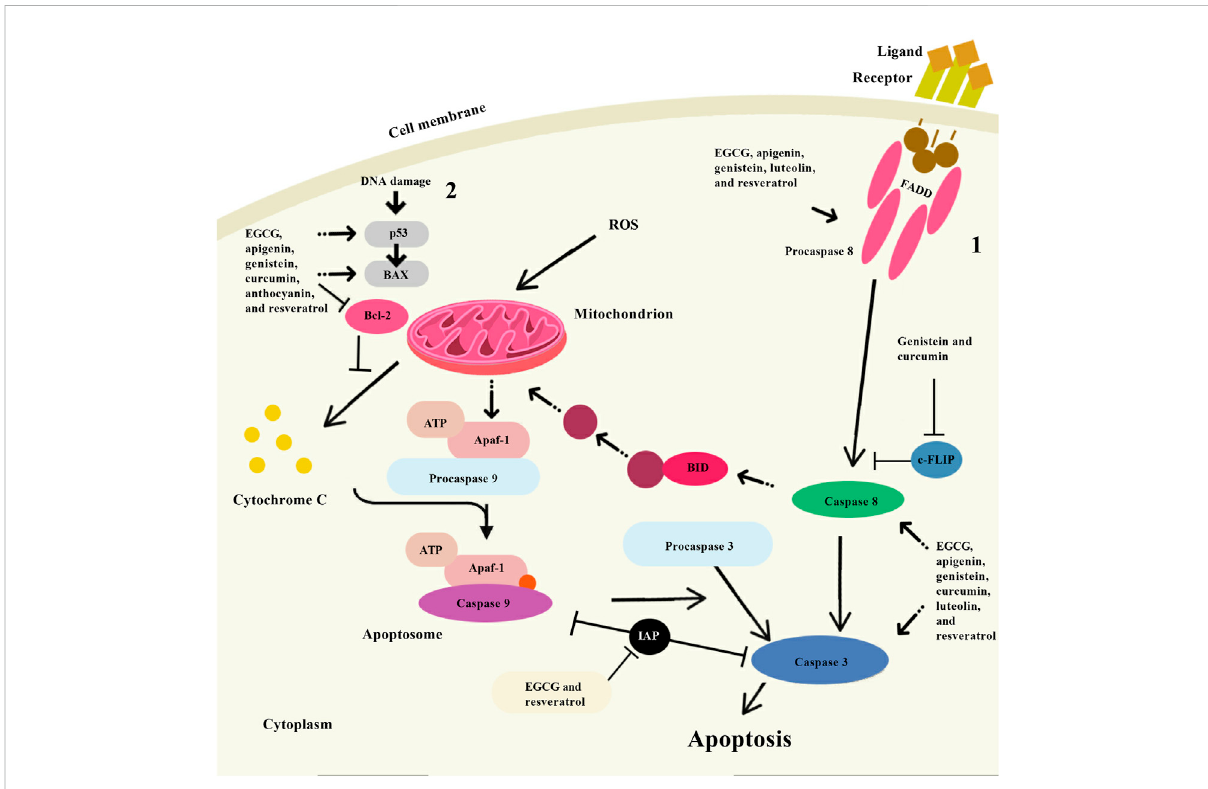
FIGURE 4 Apoptosis induction by some natural polyphenols. There are two main ways of apoptosis: 1. Apoptosis is activated by the interaction of speci fi c ligands on the cell surface with receptor proteins containing “ death domains ” ; and 2. The mitochondrial pathway of apoptosis begins with the collapse of the mitochondrial membrane potential and is accompanied by the release of cytochrome C from the mitochondrial intermembrane space into the cell cytoplasm. The vast experimental material obtained so far indicates that some natural polyphenols (epigallocatechin-3- gallate (EGCG), apigenin, genistein, luteolin, resveratrol, curcumin, and anthocyanin) have an apoptogenic effect using a variety of cellular targets. Note: BAX, Bcl-2 associated X-protein; Bcl-2, B-cell lymphoma-2; ROS, Reactive oxygen species; FADD, Fas-associated death domain;